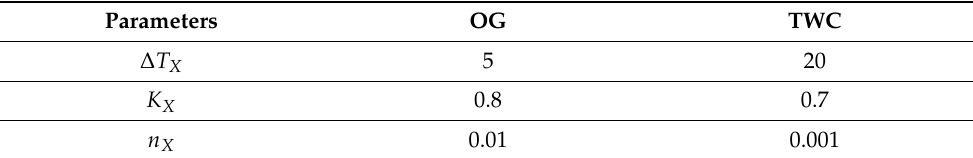
Table 2. Values of parameters for OGs and TWCs.